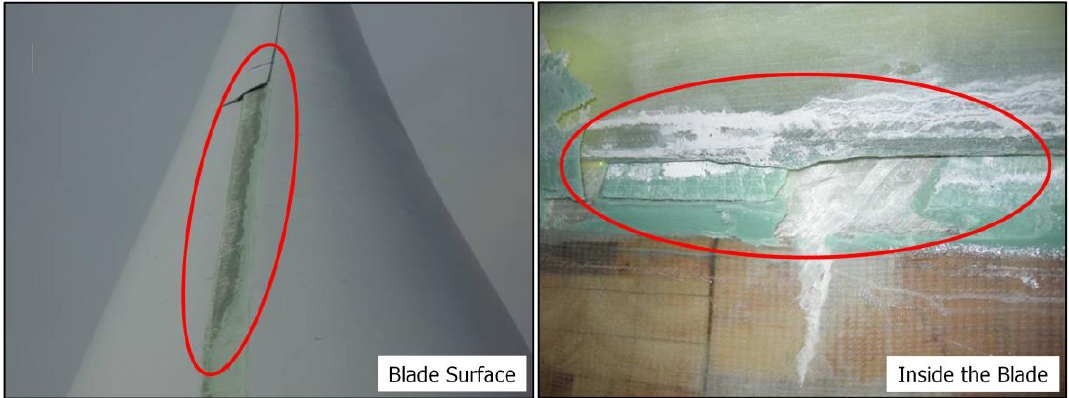
Figure 1. Photos of the blade damage.